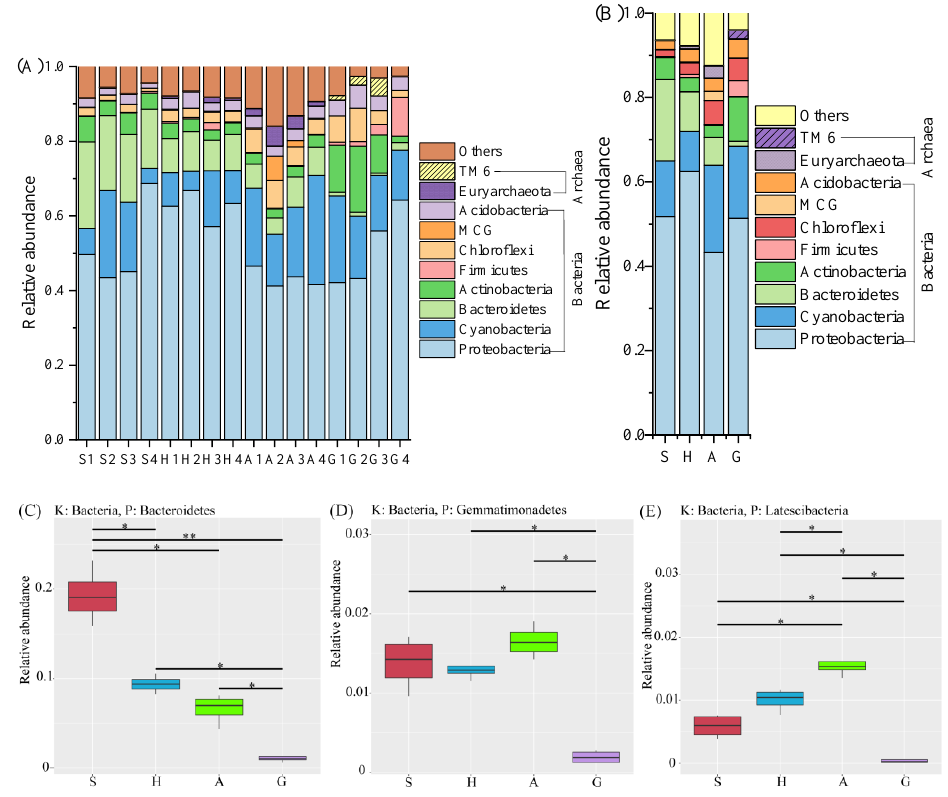
Figure 3. Relative abundances of main microbes in the worm intestine and different sediments at the phylum level. ( A ) Each sample. ( B ) Each group. ( C – E ) Differences in microbial community between intestine and different sediments. Asterisks (*) indicate significant differences ( p < 0.05, Wilcoxon test). The two asterisks (**) indicate extremely significant differences ( p < 0.01, Wilcoxon test). S—surface sediment; H—sediment in the hole; A—ambient sediment; G—gut of S. nudus